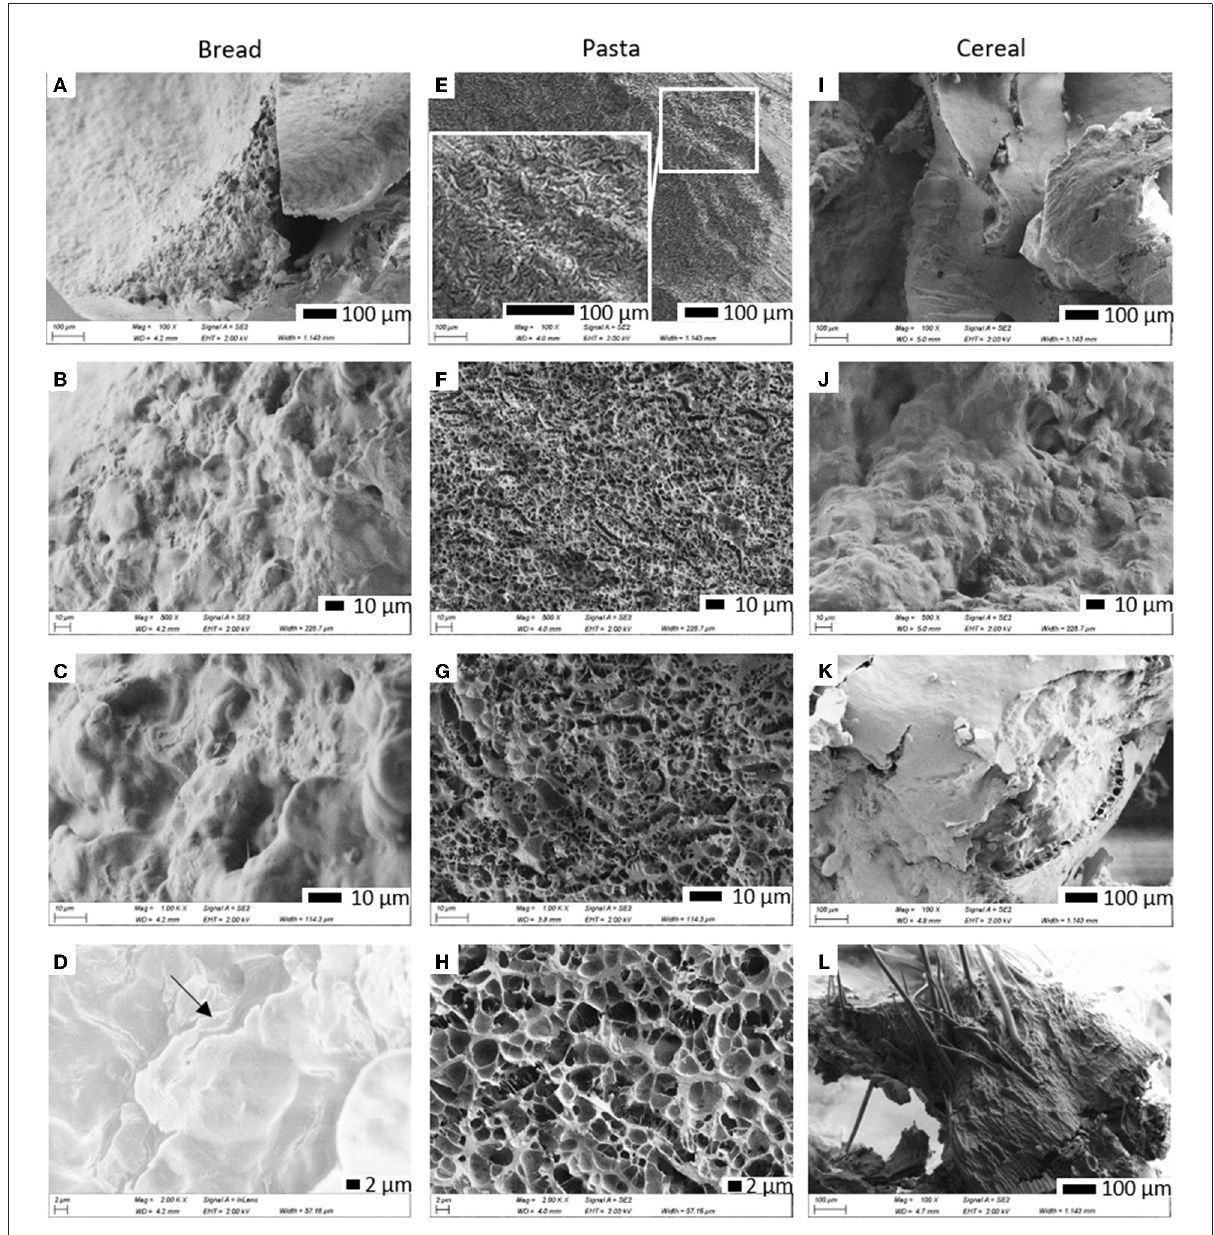
FIGURE1 Scanning electron micrographs of bread, cooked pasta and breakfast cereal at different magnifications. Micrographs show cross-sections of bread crumb (A–D) , a cross section of pasta showing the border between its outer and internal surfaces (E) and only its internal structure (F–H) and a cross section of extruded wheat biscuit (I–L) . The arrow in (D) is pointing to starch leaching out of a starch